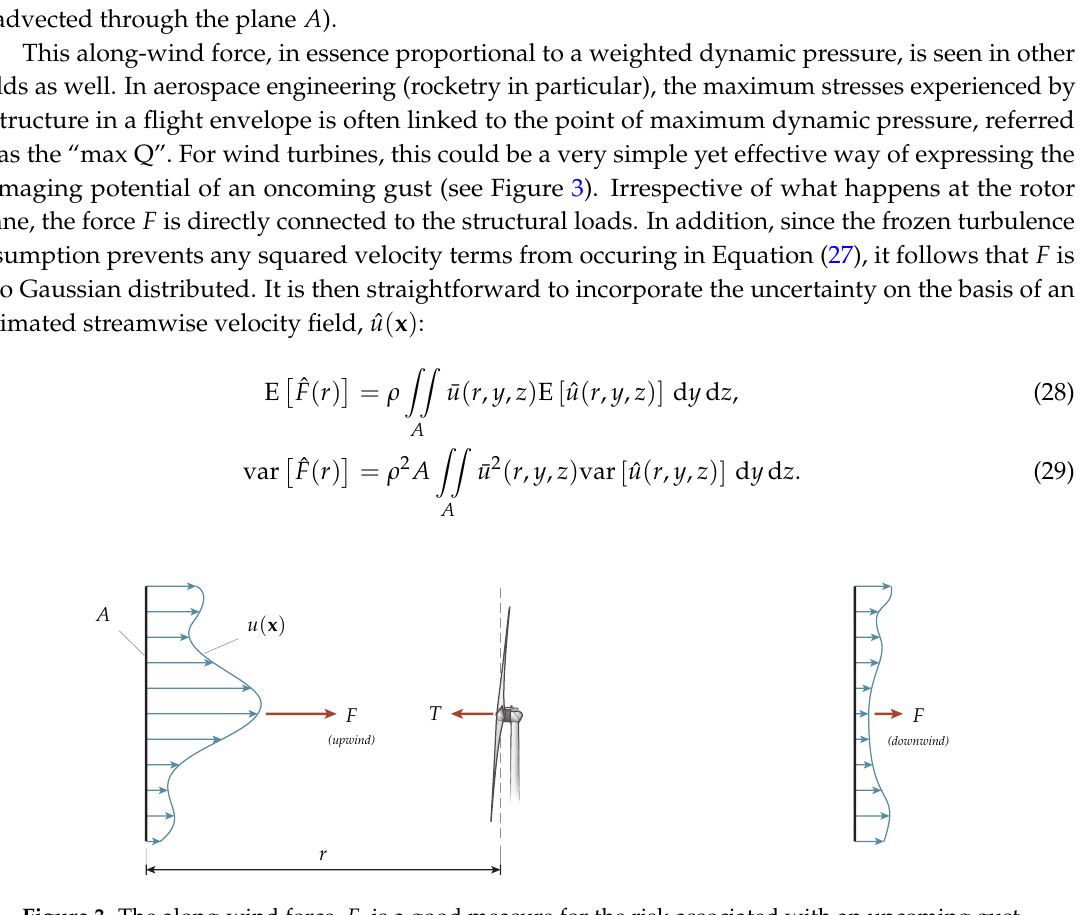
Figure 3. The along-wind force, F , is a good measure for the risk associated with an upcoming gust. The thrust force, T , which dictates the loads acting on the structure, is a result of momentum transfer between the wind and the rotor and is difficult to predict in advance. However, the severitiy (i.e., the damaging potential) of a gust, is captured by the upwind F